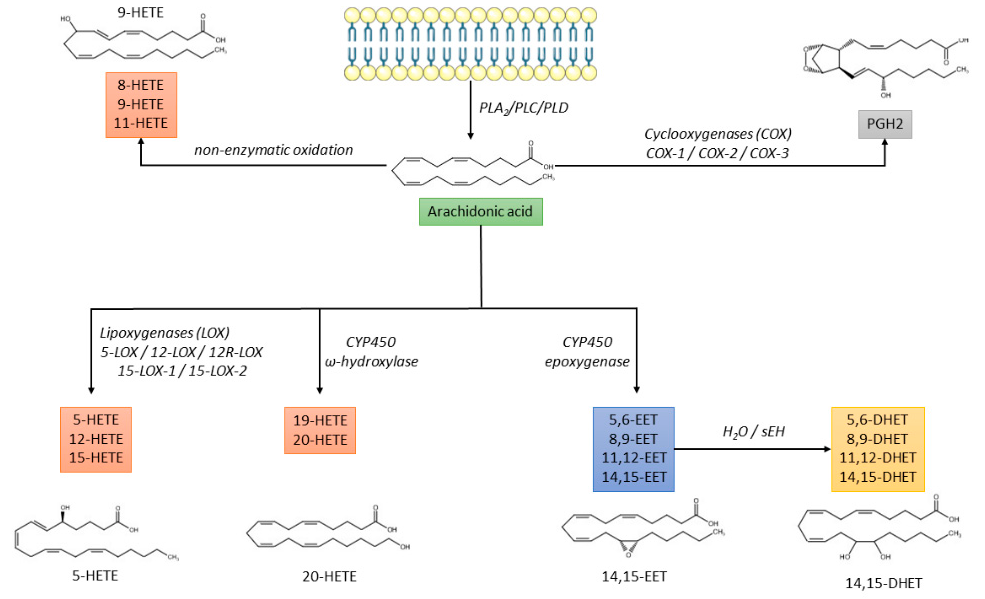
Figure 1. Biochemical pathways of arachidonic acid metabolism. CYP450: cytochrome P450; DHET: dihydroxyeicosatrienoic acid; EET: epoxyeicosatrienoic acid; HETE: hydroxyeicosatetraenoic acid; PGH2: prostaglandin H2; PL: phospholipase; sEH: soluble epoxide hydrolase.